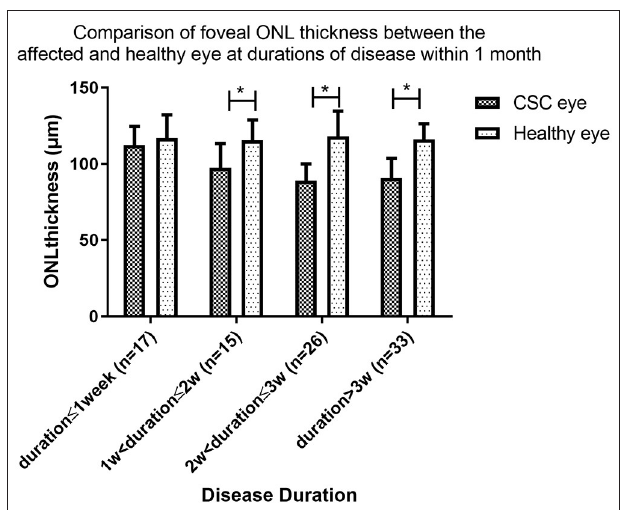
FIGURE 3 | Comparison of foveal ONL thickness between the affected and healthy eye at durations of disease within 1 month. In a subgroup analysis of Group A, ONL thickness was similar in the affected and fellow eyes of patients with central serous chorioretinopathy (CSC) disease duration of ≤ 1week ( P = 0.286), but was significantly thinner in the affected than fellow eye in patients in the following groups: (14 weeks; ( P = 0.009, P < 0.001, and P < 0.001 respectively). (* indicates statistical